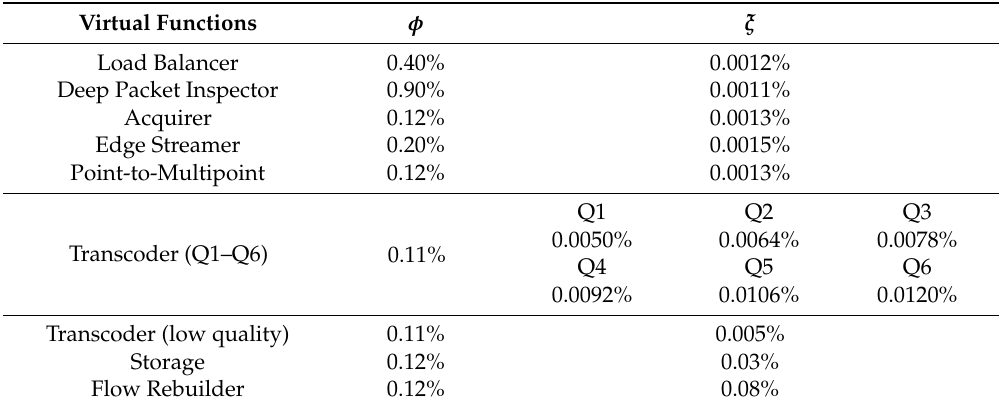
Table 1. Load parameters of the virtual functions, measured